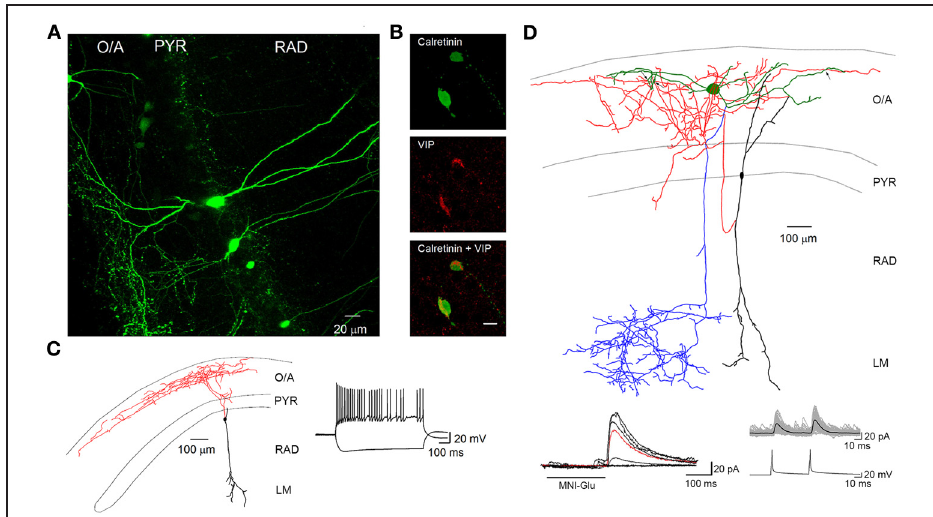
FIGURE 2 | VIP-positive interneurons at the PYR/RAD border target O–LM interneurons. (A) Maximal projection of a two-photon z-stack acquired in the CA1 region of the hippocampus of a VIP-eGFP mouse, showing bipolarly oriented VIP-positive cell bodies located at the PYR/RAD border and a dense axonal arborization in the O/A. (B) Immunofluorescence images of neurons located in PYR positive for calretinin (top) and VIP (middle) as well as their superimposition (bottom). Scale bar: 20 μ m. (C) Reconstruction of a bipolarly oriented VIP-positive cell, showing anatomical features of IS-IIIs (soma and dendrites are shown in black and axon is shown in red) and its irregularly spiking firing pattern typical for these cells. (D) Neurolucida reconstruction of a connected pair of interneurons: presynaptic IS-III (soma and dendrites are in black and axon is in red) and postsynaptic O–LM (soma and dendrites are in green, axon is in blue) and examples of unitary IPSCs evoked by two-photon glutamate uncaging (bottom left) and presynaptic spikes during paired recordings (bottom right). Black arrows indicate three putative contact sites onto O–LM dendrites. Modified from Chamberland et al.